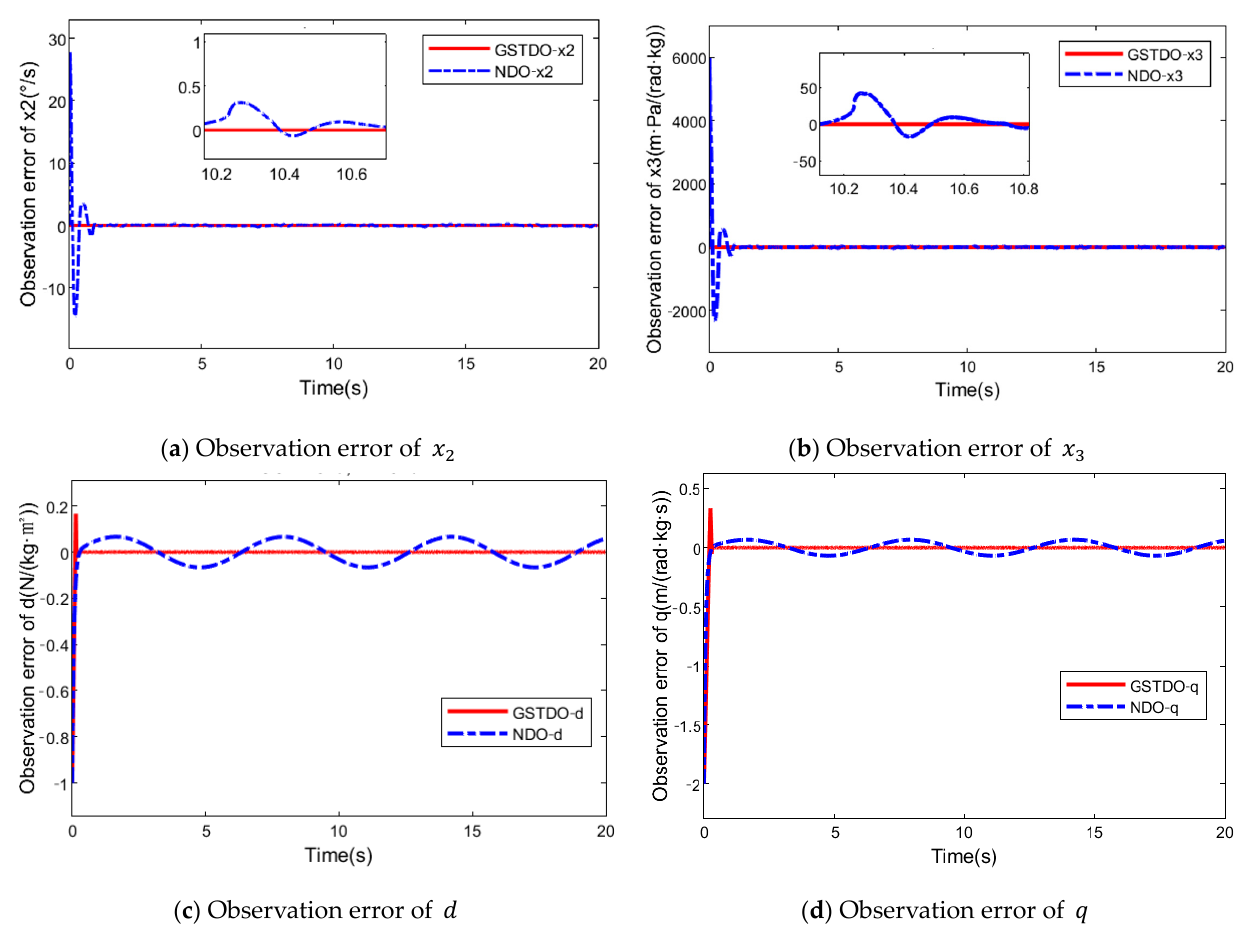
Figure 13. Comparison of the observational e ff ects of GSTDO and NDO in Experiment 2.